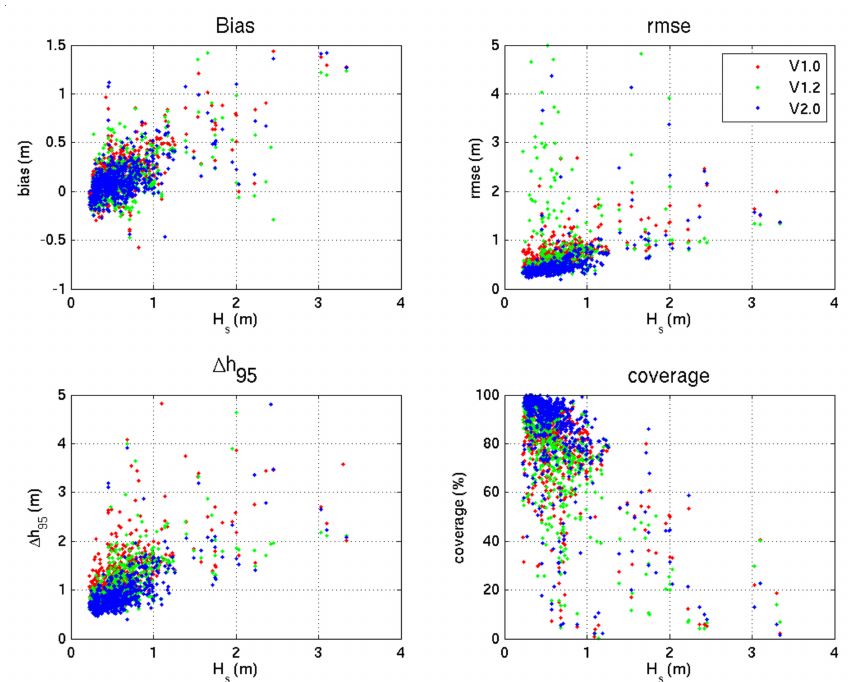
Figure 16. Scatter plots of the four performance statistics for each of the three algorithm versions (see legend at top right) for the full dataset of 624 runs. Points are plotted in order, so blue points (V2.0) overplot earlier versions.